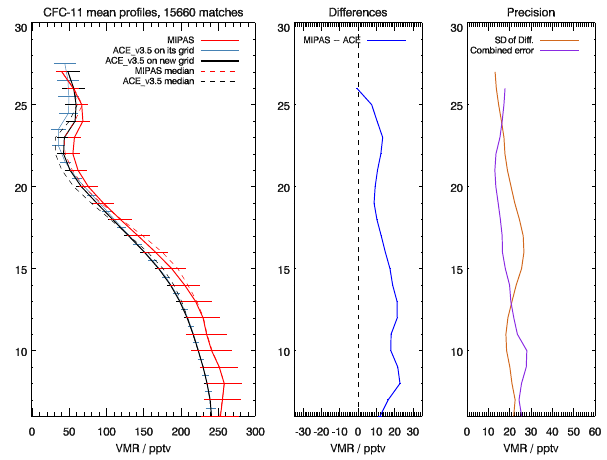
Figure 11. Comparison of mean profiles of MIPAS CFC-11 (left panel, continuous red line) and ACE-FTS (left panel: blue line denotes ACE-FTS on native grid; continuous black line denotes ACE-FTS interpolated onto the MIPAS grid) for the years of 2005– 2012. The error bars include the total error for MIPAS and the ran- dom errors from the least-squares fitting process for ACE-FTS. The dashed lines show the median of each data set. The middle panel shows the mean difference (blue) of these profiles and the standard error of the mean. The right panel shows the combined error (pur- ple) of the instruments and the standard deviation of the differences